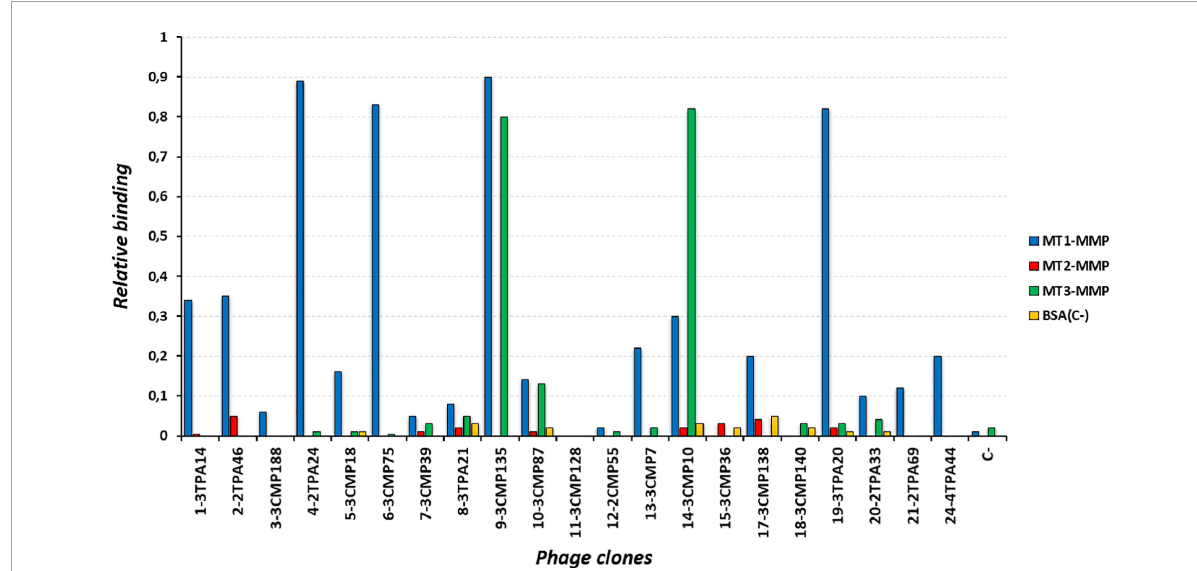
FIGURE1 Reactivity of different clones representing most of the complementarity determining region 3 (CDR3) groups by phage ELISA against membrane type 1-matrix metalloproteinase (MT1-MMP) (blue bars) and other related members of the protein family, membrane-type matrix metalloproteinase subgroup, MT2-MMP (red bars) and MT3-MMP (green bars). Bovine serum albumin (BSA) (orange bars) was used as negative control. Number at the beginning of each phage clone denotes the CDR3 group at which it